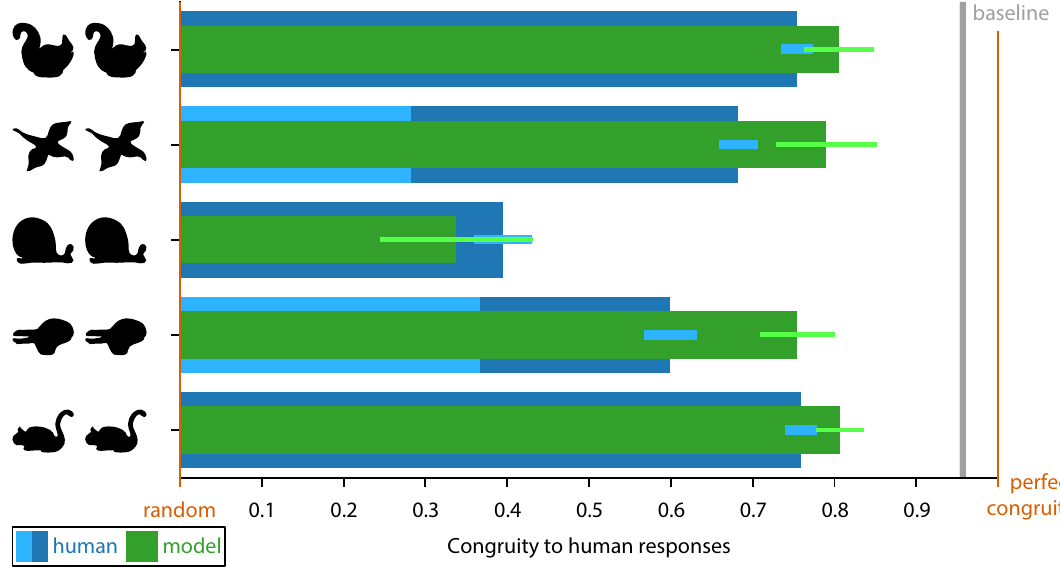
Figure 10. Human results and semantic organization model for Experiment 2. We plot response congruity on a continuum between random (0.0: congruity between responses of random model) and perfect congruity to human responses (1.0: all responses on top of each other). For the Parrot–Goose pair, we also report congruity when measured across the two response types (light blue bar, see text for explanation). For the Duck–Rabbit pair, we also report congruity when measured across the two semantic interpretations (light blue bar, see text for explanation). For other details see Fig.